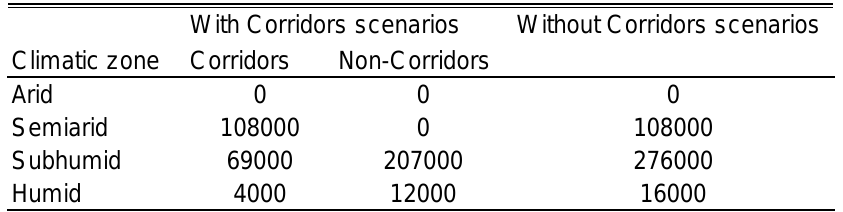
Table A2.1. Deforested area in the simulations under scenarios with low deforestation rates in each stratum of the province regarding climatic and land planning zones. In scenarios without corridors there are no land-use planning zones